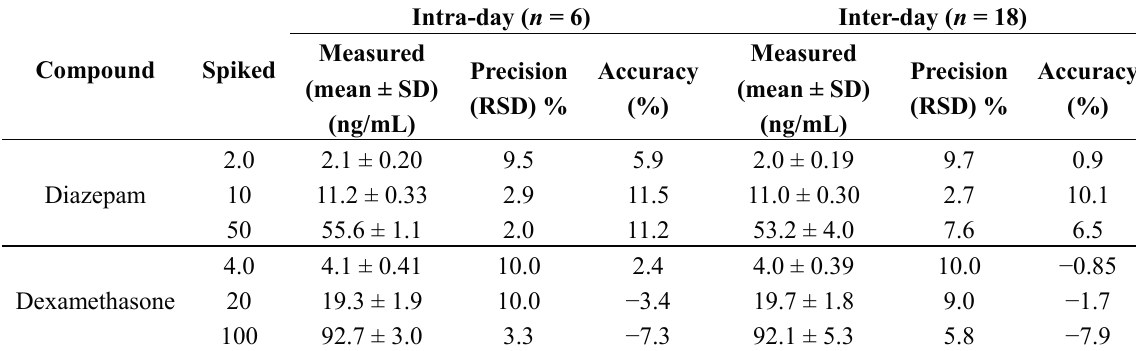
Table 1. Precision and accuracy of diazepam and dexamethasone in rat plasma.